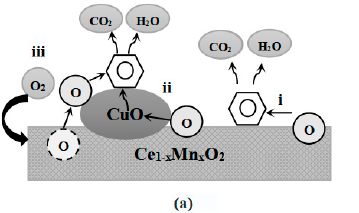
Figure 5. ( a ) Mechanism of benzene oxidation over CuO/Ce 1 − x Mn x O 2 catalysts [113]; ( b ) Mechanism of benzene oxidation over Pd-Au/TiO 2 catalyst [108]; ( c ) Mechanism of benzene oxidation over Pt/Al 2 O 3 catalyst [116].